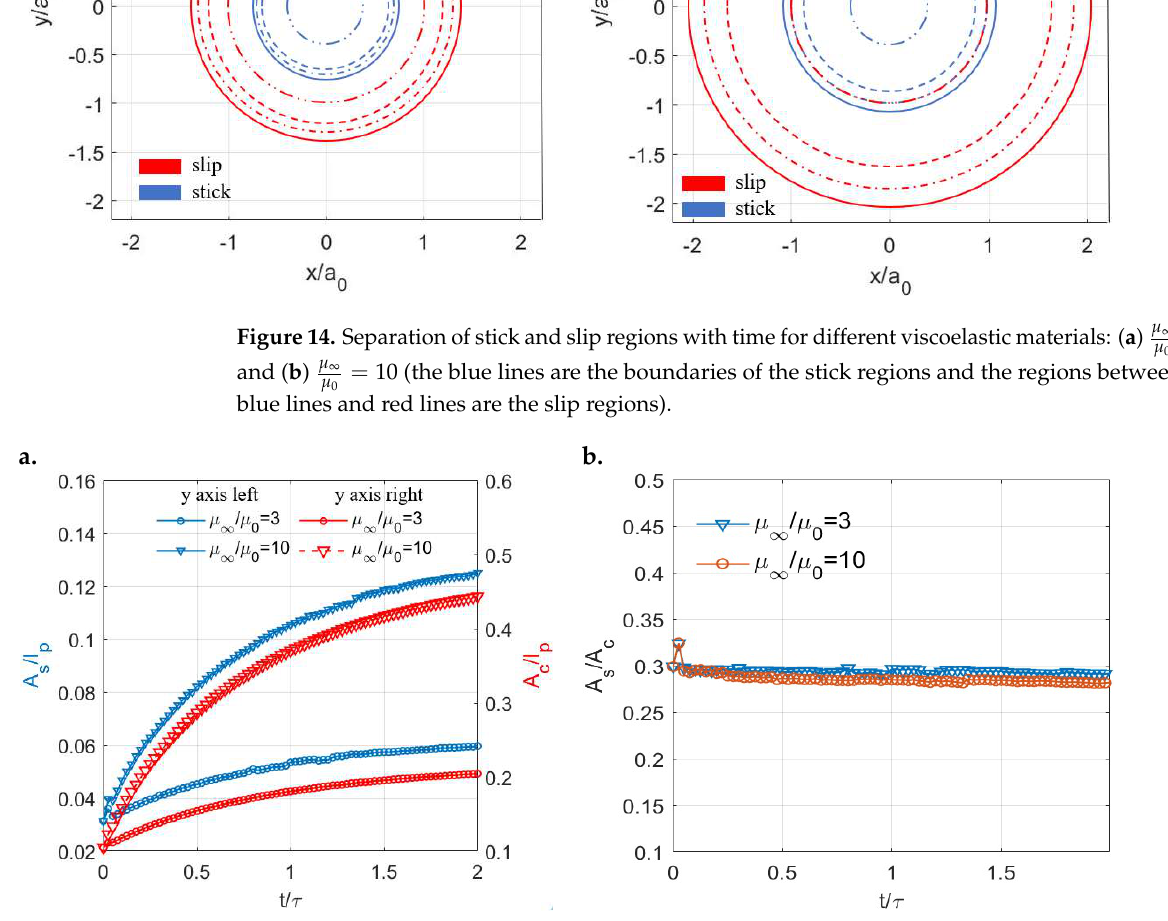
Figure 15. Simulation solutions of different viscoelastic materials under normal load alone: ( a ) Vari- ations in the ratios of the stick region ( A s / I p , left y axis) and contacting region to the simulation domain ( A c / I p , right y axis) with time for different viscoelastic materials and ( b ) Variations in the ratios of the stick region to the contacting region (short for stick ratio: A s / A c ) with time for different viscoelastic materials.